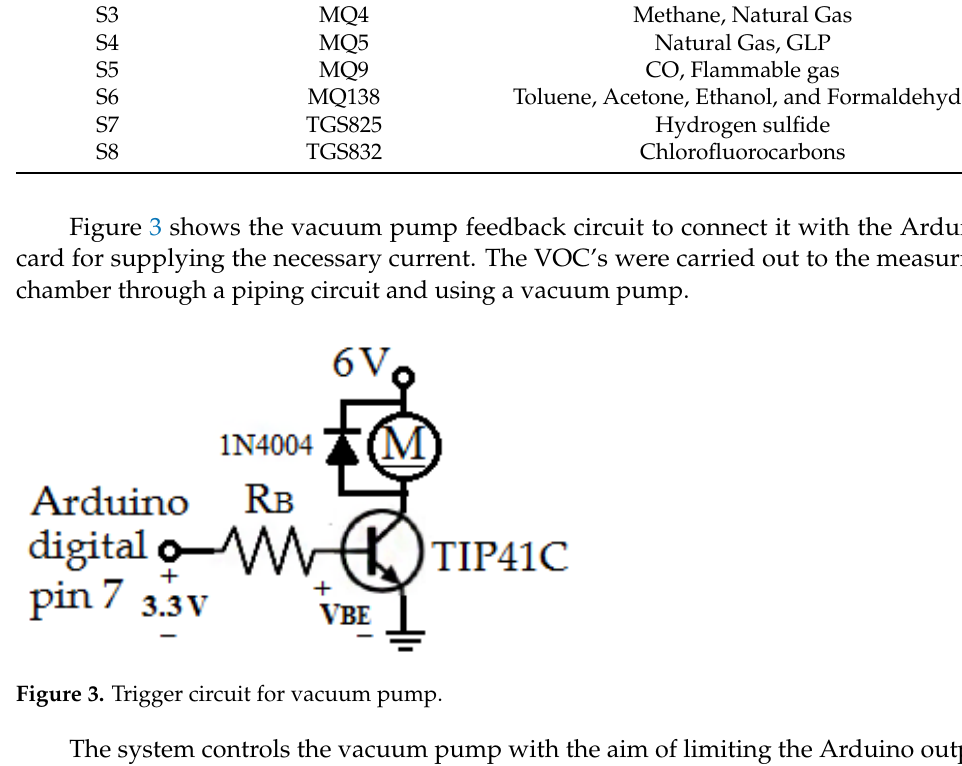
Table 2. Chemical-resistive sensors for the Electronic Nose (E-nose).